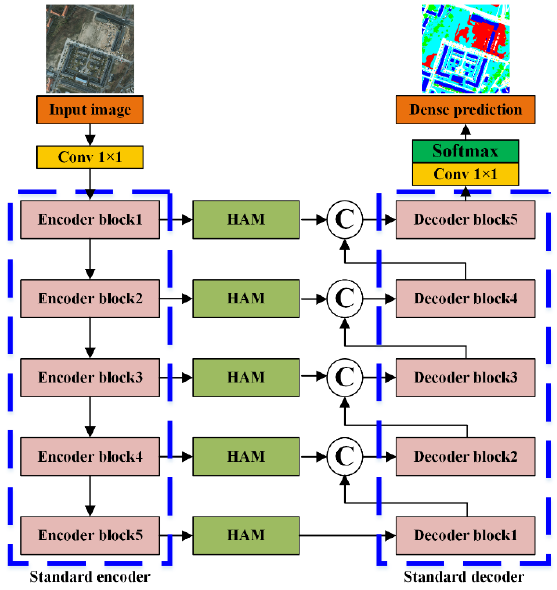
Figure 2. Overall framework of EDENet.